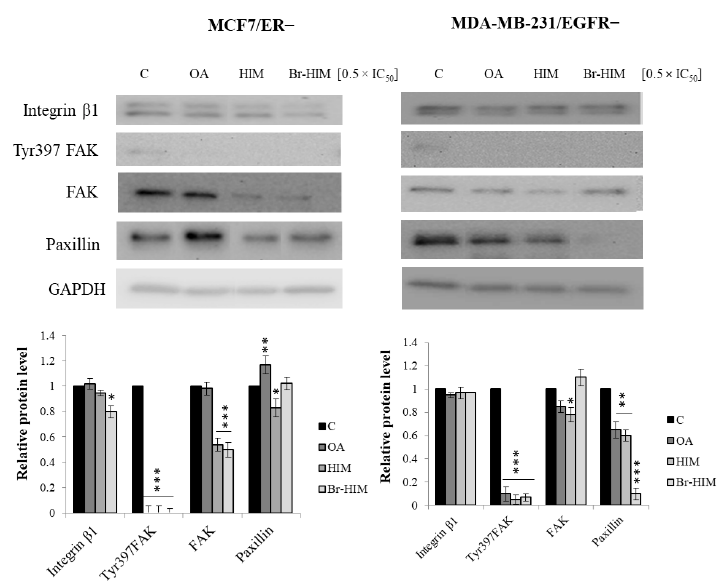
Figure 7. Alterations in proteins mediating adhesion. Evaluation of integrin β 1, Tyr397FAK, total FAK, and paxillin levels in MCF7/ER − and MDA-MB-231/EGFR − cells treated with OA or its derivatives for 24 h was performed using Western blot. Data from two independent experiments are shown as mean ± SD. * p < 0.05; ** p < 0.005; *** p < 0.001.